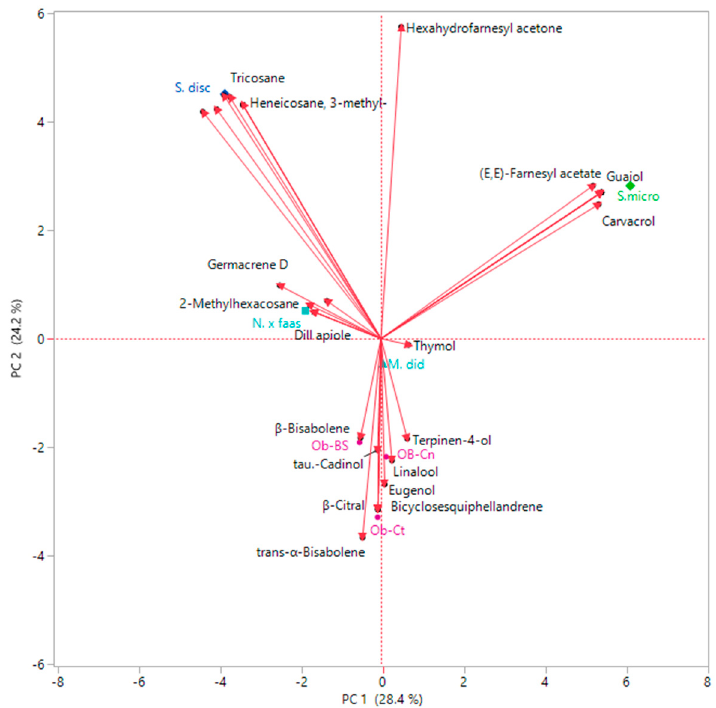
Figure 5. PCA plot depicting phytochemical proximities among the essential oils (EOs) of the studied spp.